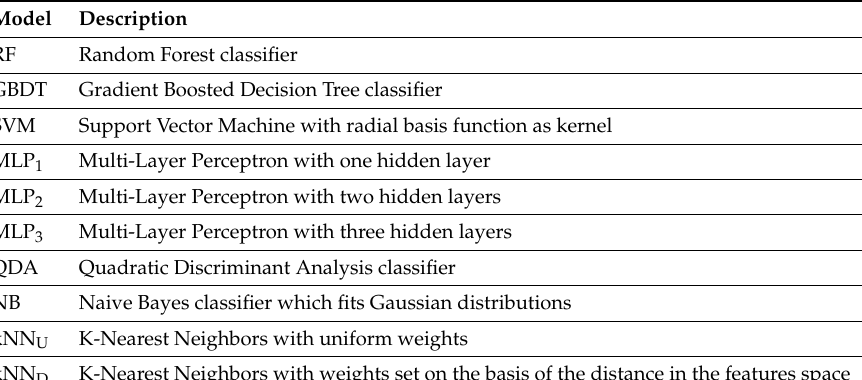
Table 2. Classification models considered in this